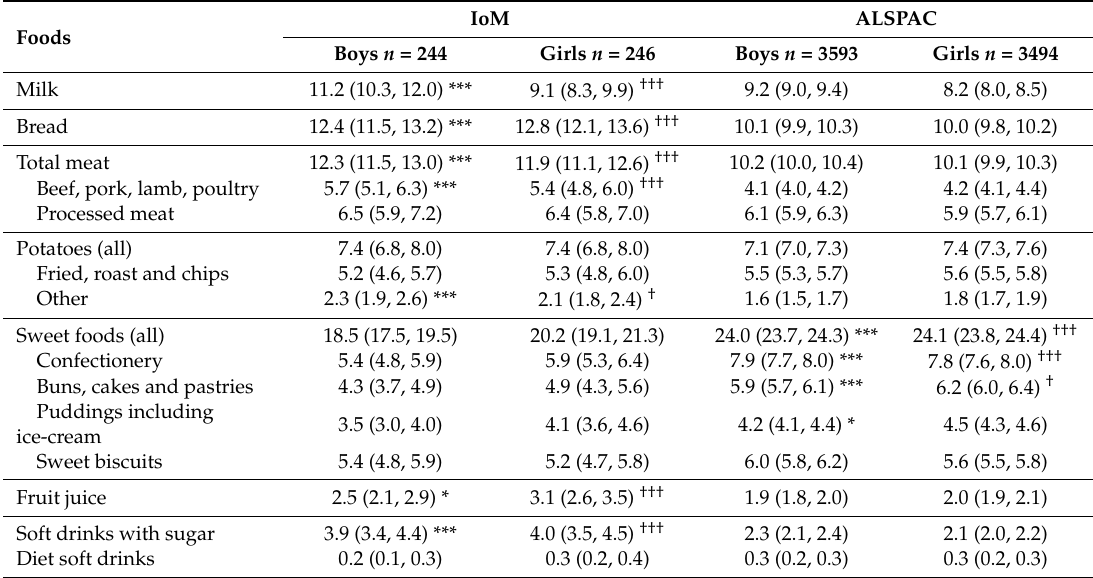
Table 5. Percentage of energy derived from individual food items from food records in 7-year-old children: comparison of IoM with ALSPAC by